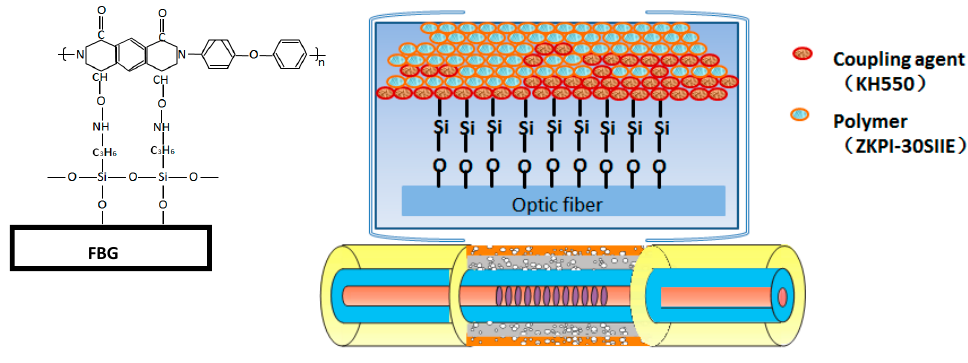
Figure 1. Structure of a coated FBG sensor.